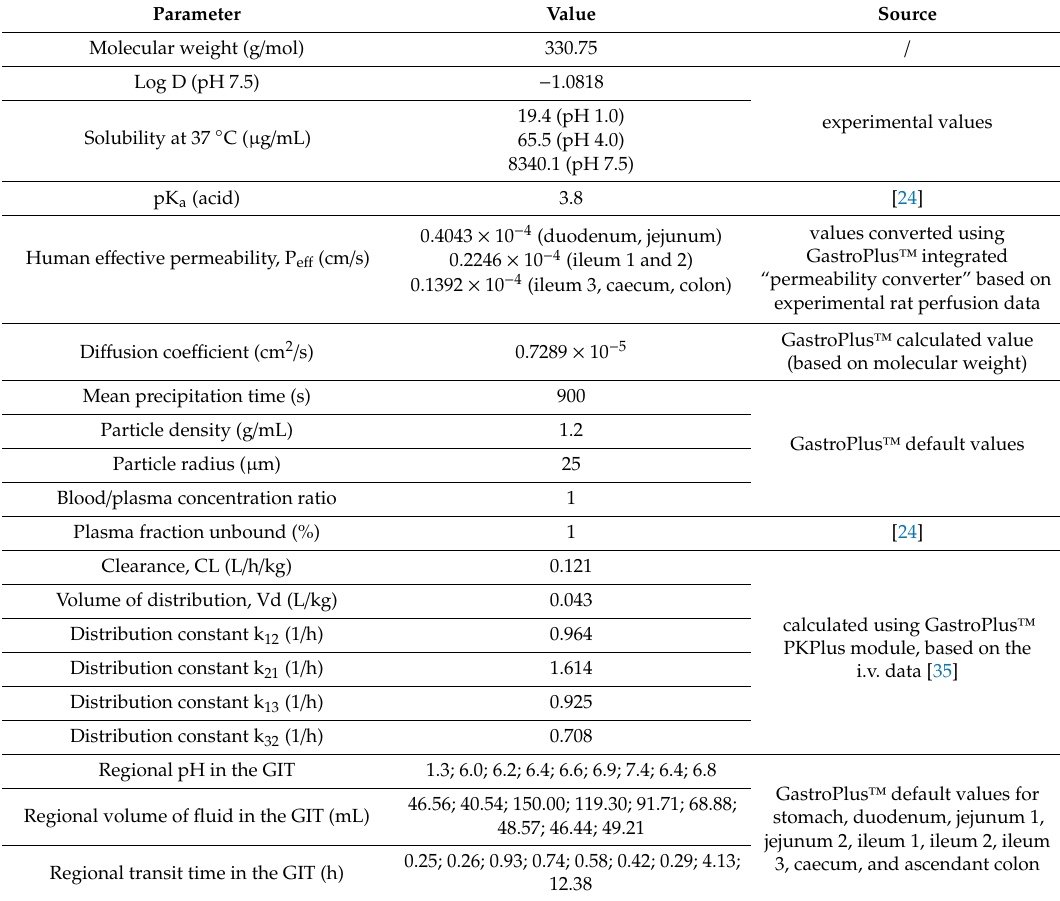
Table 3. The selected input parameters for furosemide absorption GastroPlus ®